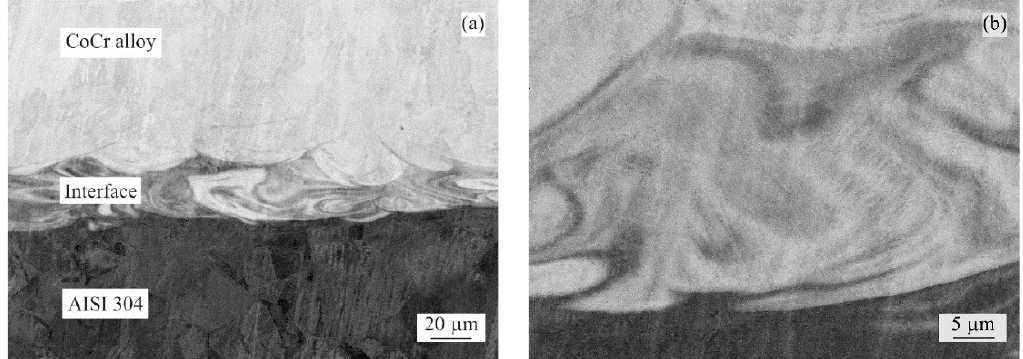
Figure 11. CoCr – 304 steel interface: ( a ) overview; ( b ) detailed image (×3000 magnification).